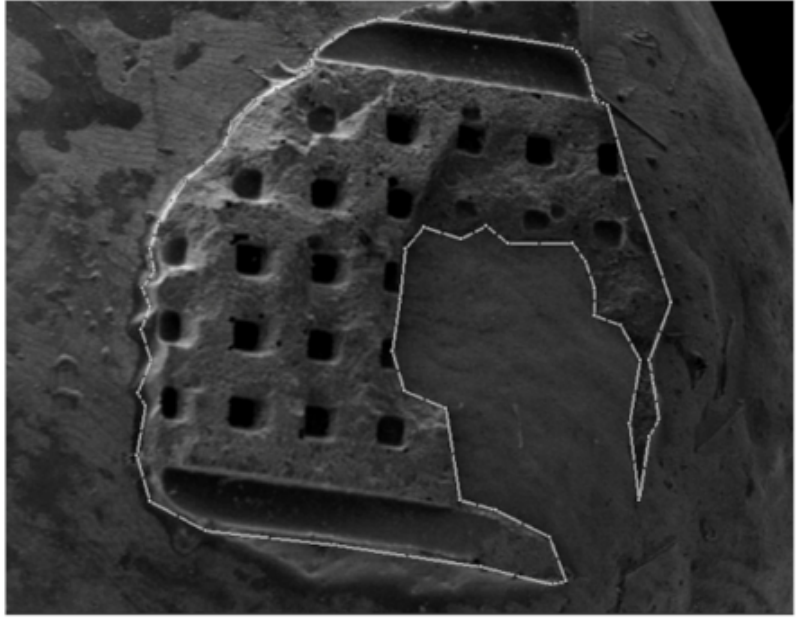
Figure 2. Scanning electron microscopy image (JEOL JSM5410, 15 × magnification) of the area of adhesive remaining on the enamel, outlined and calculated with CAD Rysunek 3.48